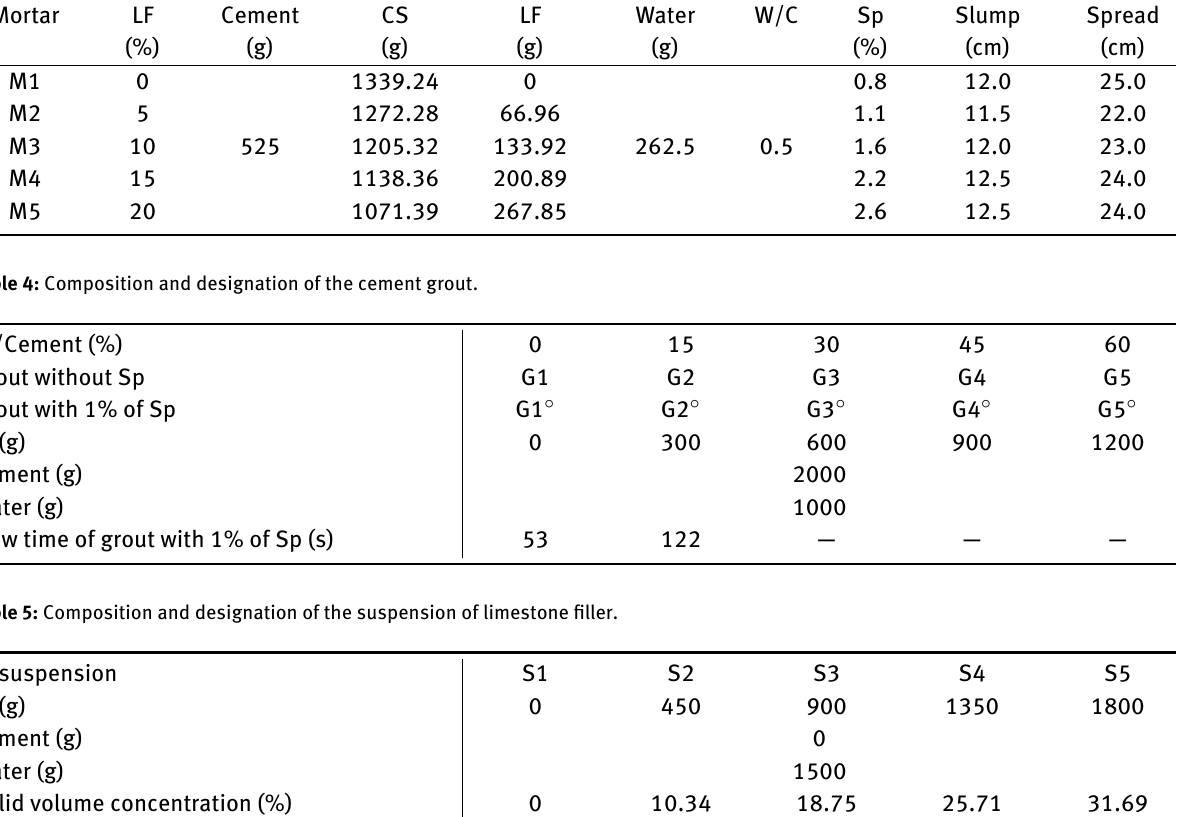
Table 3: Concrete equivalent mortar composition.